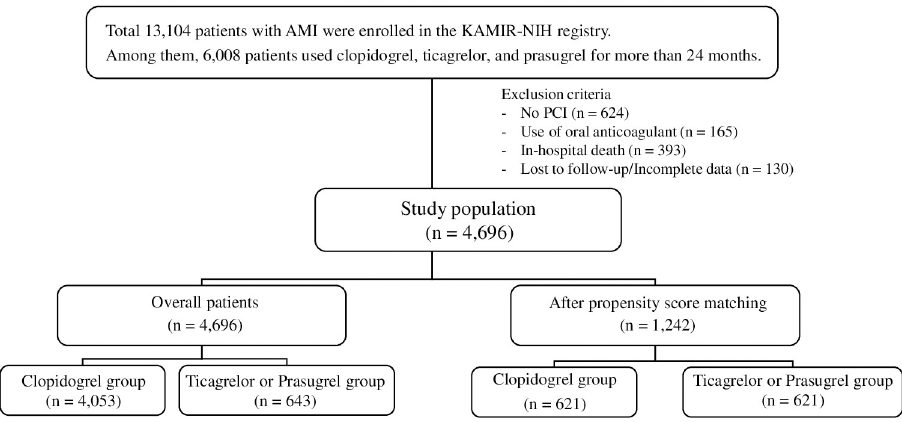
Fig 1. Study flow chart. AMI: acute myocardial infraction, KAMIR-NIH: Korean Acute Myocardial Infarction Registry National Institutes of Health, PCI: percutaneous coronary intervention.